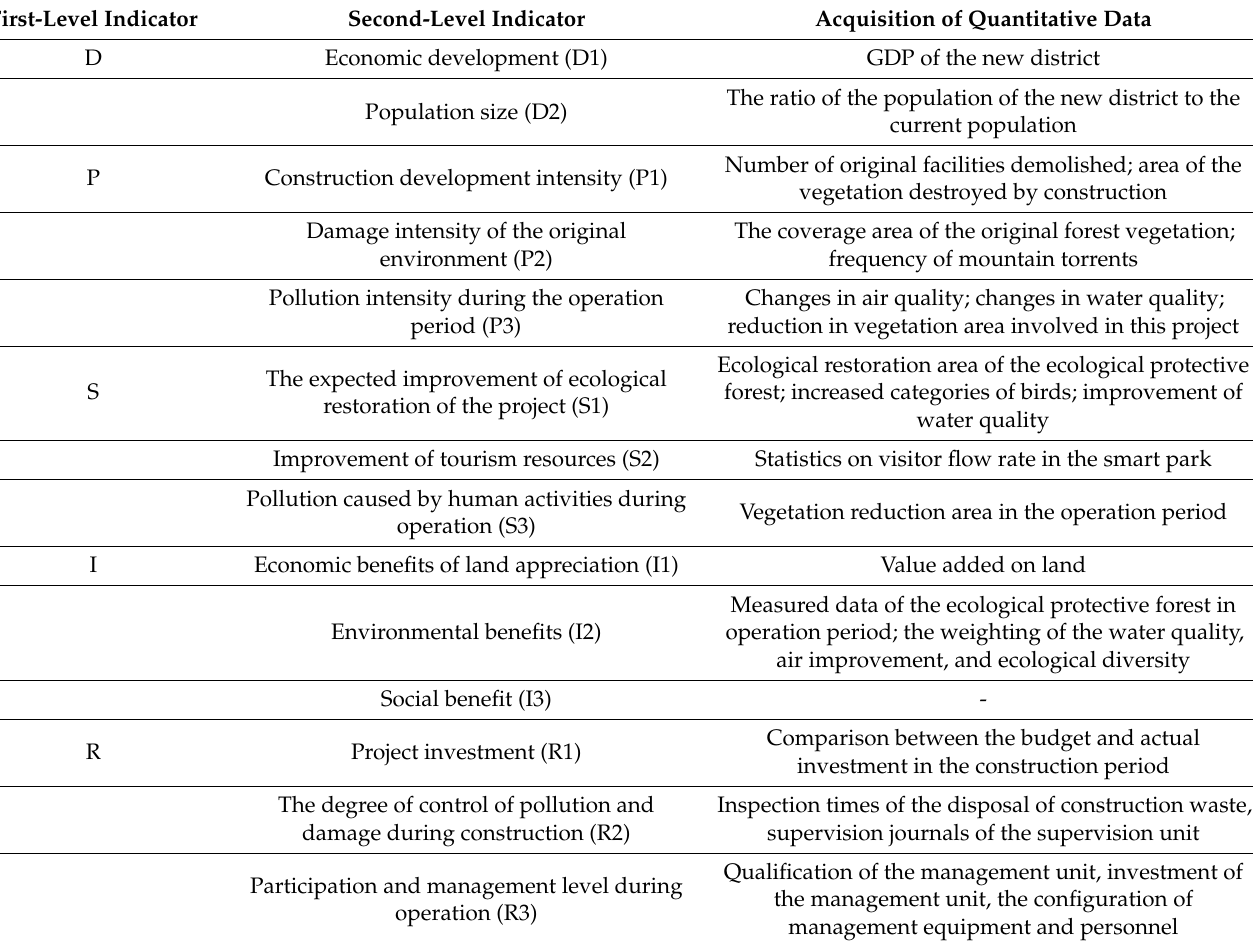
Table 6. Research directions for quantification of